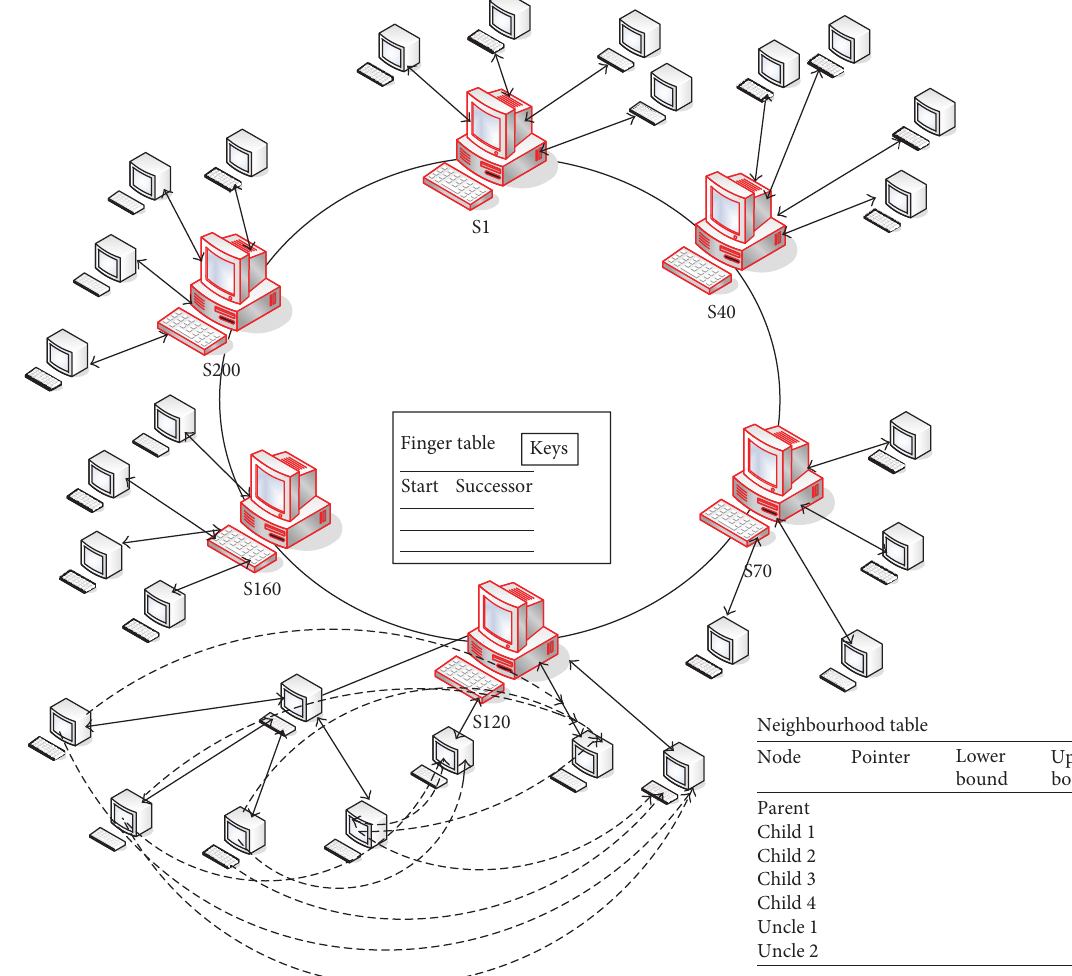
Figure 1: Proposed hierarchical overlay